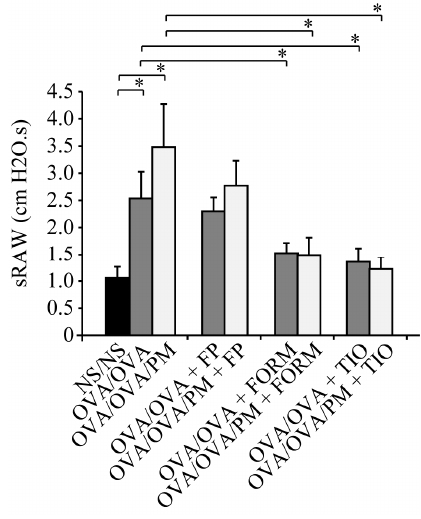
Figure 5. Effects of fluticasone propionate, formoterol fumarate, and tiotropium bromide on airway resistance. Airway resistance was evaluated by specific airway resistance (sRaw) values on day 27. Formoterol fumarate and tiotropium bromide decreased the sRaw values compared with fluticasone propionate. Data for each group are expressed as the mean ± standard deviation, with eight mice per group. * p < 0.05.